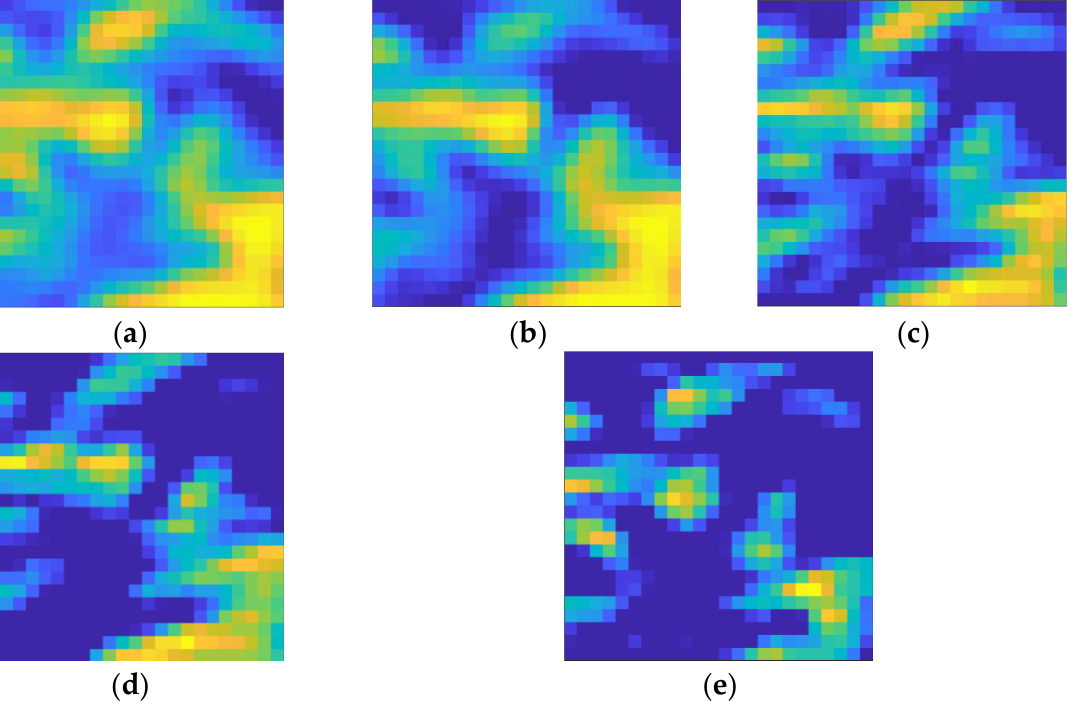
Figure 17. The visualization of image patches and the corresponding feature-maps: ( a ) The image patch extracted from the original image; ( b ) The image patch extracted from the smoothed image; ( c ) a feature-map of the original image patch; ( d ) a feature-maps of the smoothed image patch; ( e ) a different feature-map of the original image patch.